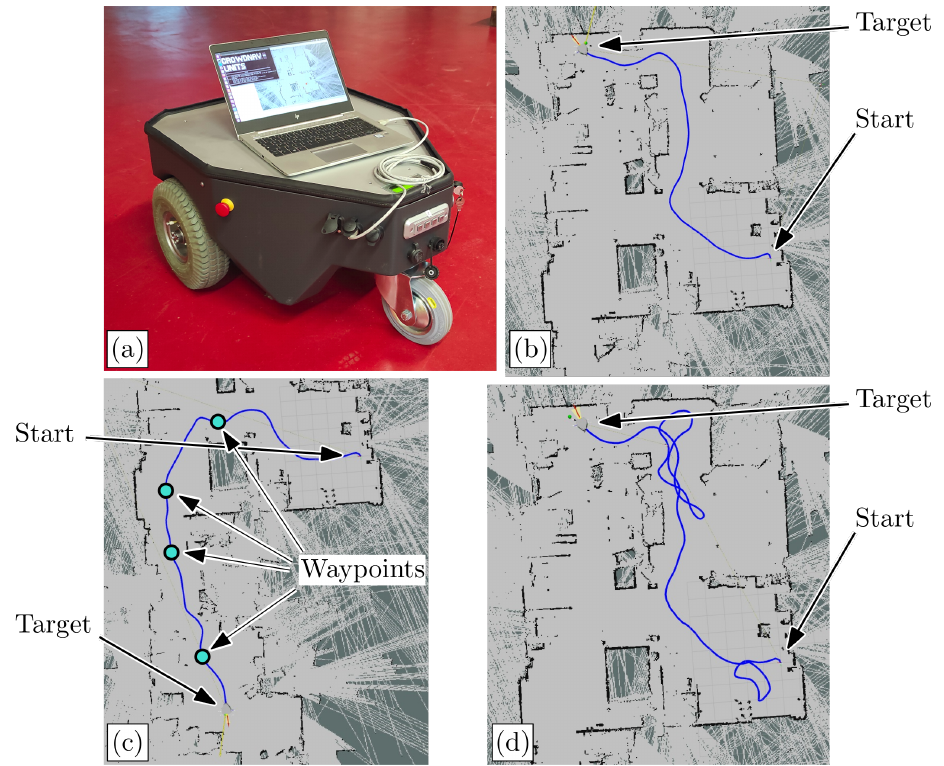
Figure 15. Prototype demonstration. ( a ) The Neobotix MP-500 differential drive mobile robot used in the experimental campaign; ( b ) trajectory of the mobile robot for the point-to-point motion in the absence of dynamic obstacles; ( c ) the trajectory of the mobile robot for the path following through given way-points in the absence of dynamic obstacles; ( d ) the trajectory of the robot for the point-to- point motion in the presence of moving pedestrians as dynamic